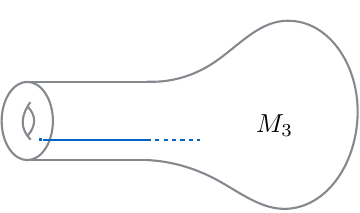
1 ; : : : ; t 1 ; t N 1 ending (cid:0) (cid:0) g